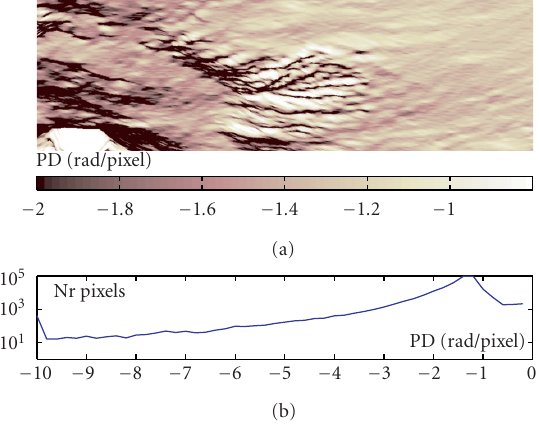
Figure 6: (a) Wanted PD image scaled in the [ − 3 : 0] interval to retain the dynamic and (b) the PD